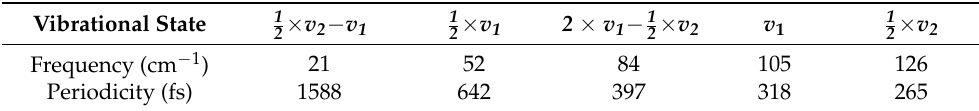
Table 3. The frequency of FFT and their allocation. ν 1 represents 10b 1 vibration mode, and the vibration frequency is 103 cm − 1 ; ν 2 represents the 16a 1 vibration mode with a vibration frequency of 246 cm − 1